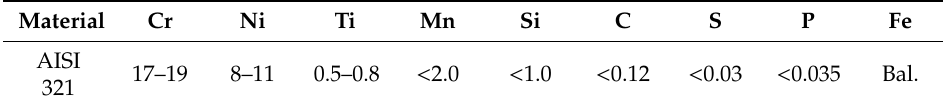
Table 3. Chemical composition of AISI 321